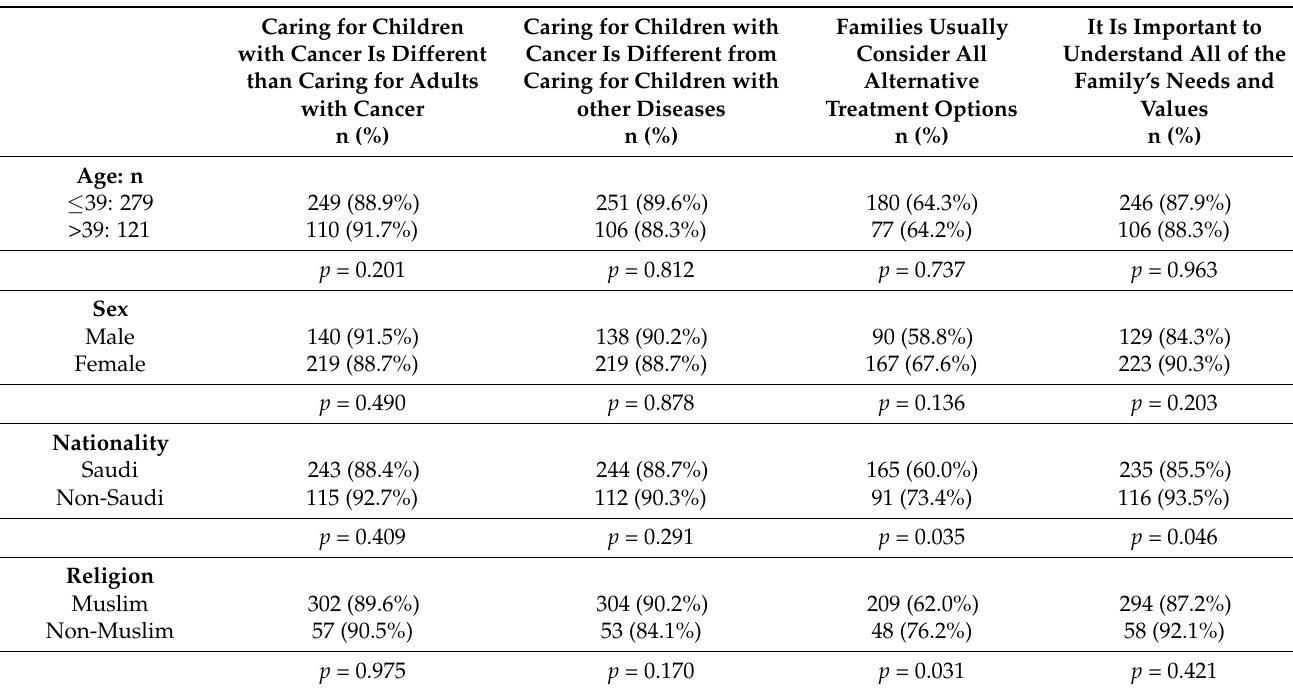
Table 3. Awareness of pediatric cancer care across sample